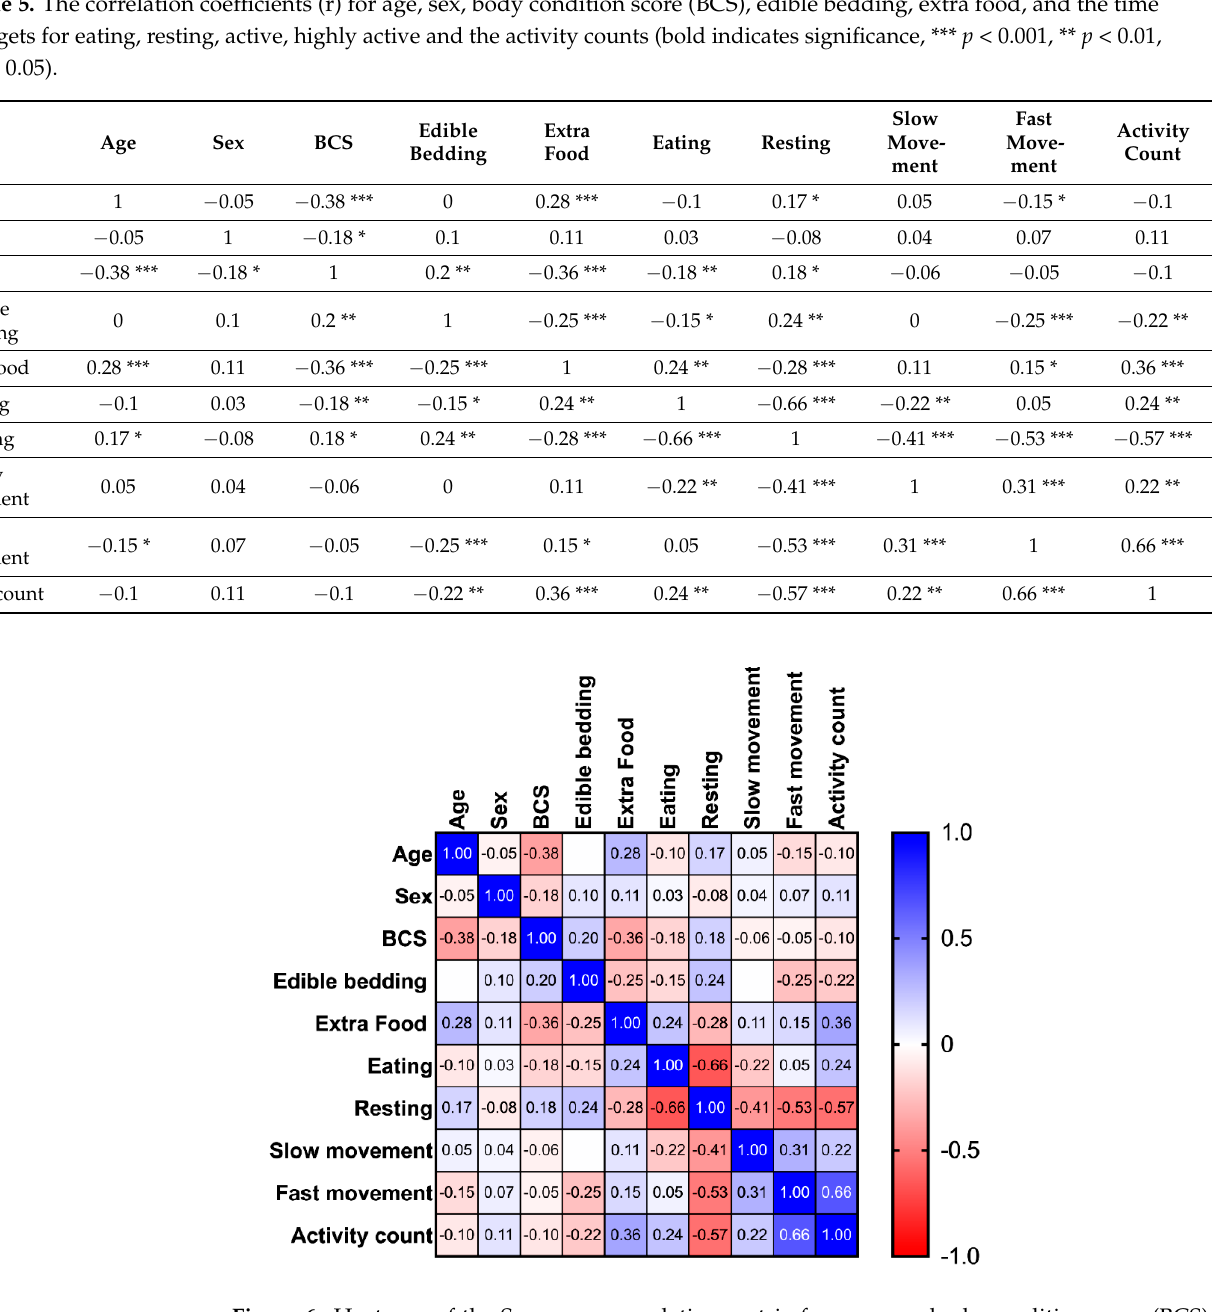
Figure 6. Heatmap of the Spearman correlation matrix for age, sex, body condition score (BCS), edible bedding, extra food, the time budget for eating, resting, slow movement and fast movement and the activity count.